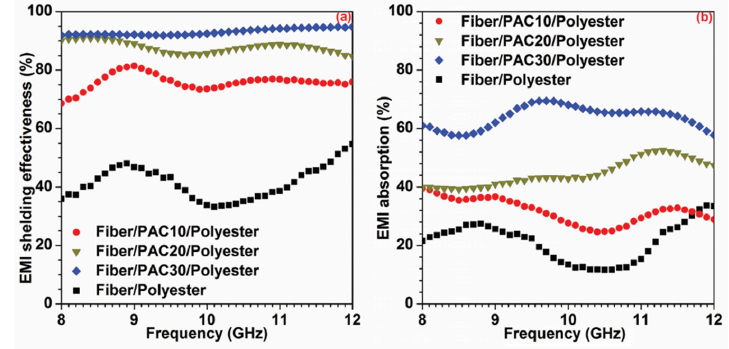
Figure 5. EMI shielding effectiveness ( a ) and absorption ( b ) of the four composites.